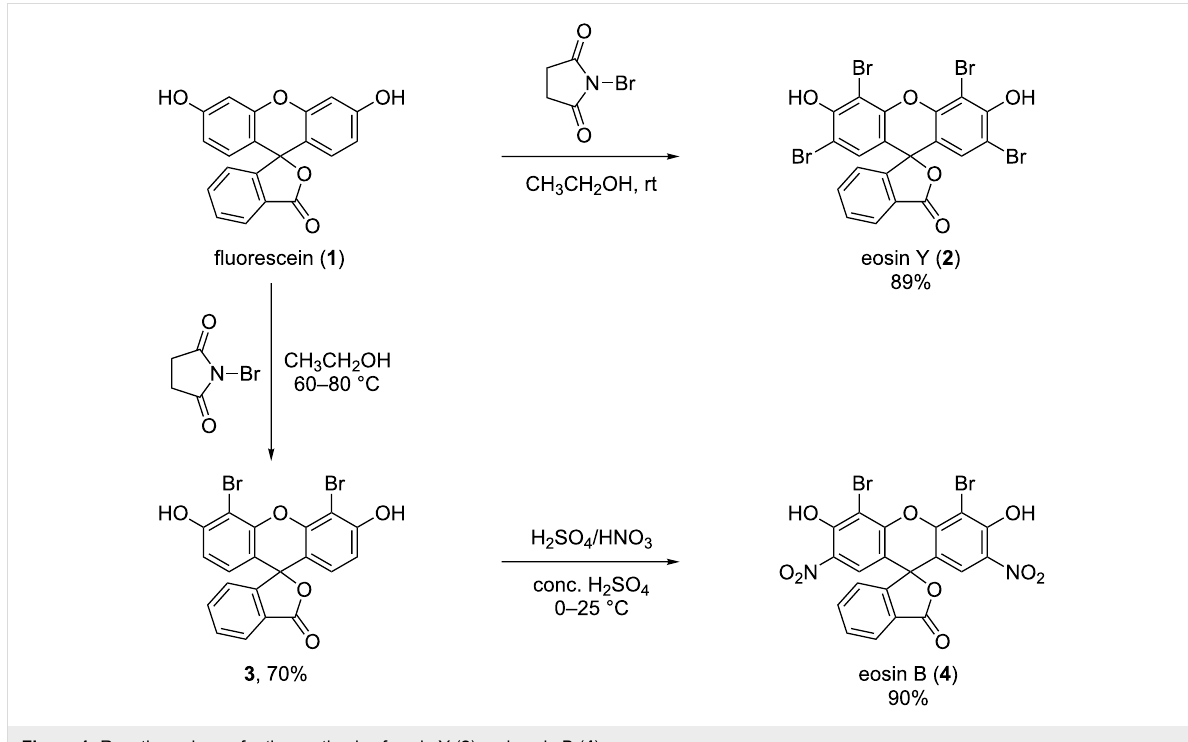
Figure 1: Reaction scheme for the synthesis of eosin Y ( 2 ) and eosin B ( 4 ).